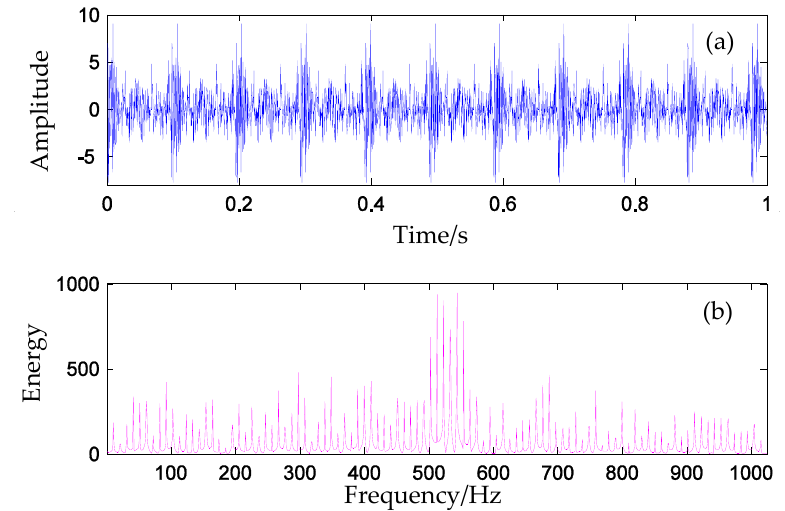
Figure 7. Simulation signal in ( a ) time domain and in ( b ) frequency domain.